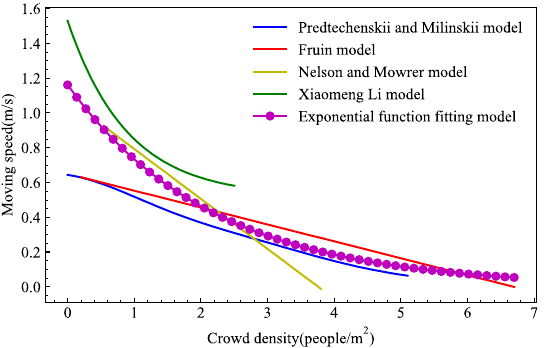
Figure 10. The fitting speed model of evacuees descending stairs.